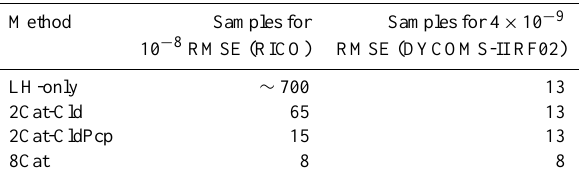
Table 6. Number of sample points needed by each configuration of SILHS to achieve a given RMSE in estimating the sum of the three processes, for the RICO and DYCOMS-II RF02 cases. These numbers are estimated visually from Figs. 1 and 5. In RICO, the 2Cat-CldPcp method requires approximately a factor of 4 fewer sample points than the 2Cat-Cld method to achieve an RMSE of 10 − 8 kgkg − 1 , and 8Cat method requires approximately a factor of 8 fewer sample points. In DYCOMS-II RF02, the 8Cat method re- quires approximately a factor of 1.6 fewer sample points than the 2Cat-CldPcp, 2Cat-Cld, and LH-only methods to achieve an RMSE of 4 × 10 − 9 kgkg − 1 .